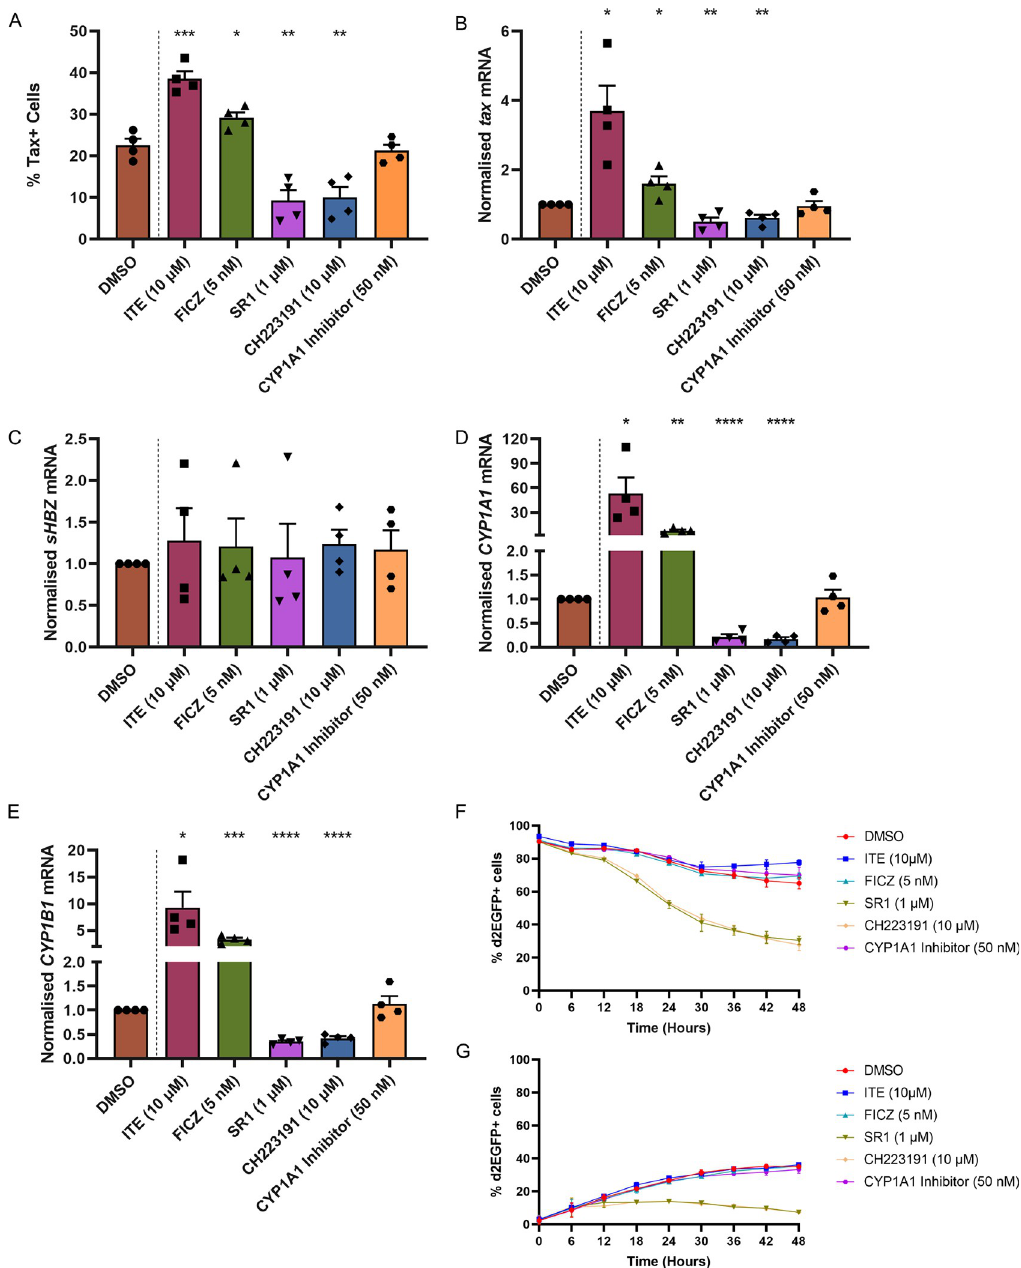
Fig 8. AhR signalling enhances HTLV-1 plus-strand expression. (A) Two patient-derived HTLV-1 infected T -cell clones were treated with AhR agonists or antagonists or CYP1A1 inhibitor for 48 hours at the indicated concentrations. DMSO was used as the vehicle control. The percentage of plus-strand expressing cells among viable cells was quantified by Tax protein expression using flow cytometry. The bar plot depicts the mean and SEM from two independent experiments. Unpaired two- tailed t-tests were used to determine the significance of the difference between the vehicle control and the treatment conditions. � P < 0.05, �� P < 0.01, ��� P < 0.001. Expression levels of (B) tax (plus-strand), (C) sHBZ (minus-strand), AhR target genes (D) CYP1A1 and (E) CYP1B1 quantified by RT-qPCR after 24-hour treatment with DMSO, AhR activators or inhibitors or CYP1A1 inhibitor. Bar plots represent the mean and SEM from two independent experiments using two T-cell clones. � P < 0.05, �� P < 0.01, ��� P < 0.001, ���� P < 0.0001 (unpaired two-tailed t-test). Proviral (F) silencing and (G) reactivation kinetics in response to treatment with AhR agonists and antagonists. The data depict mean ± SEM from two independent experiments using a single clone. Individual trajectories are shown in S5